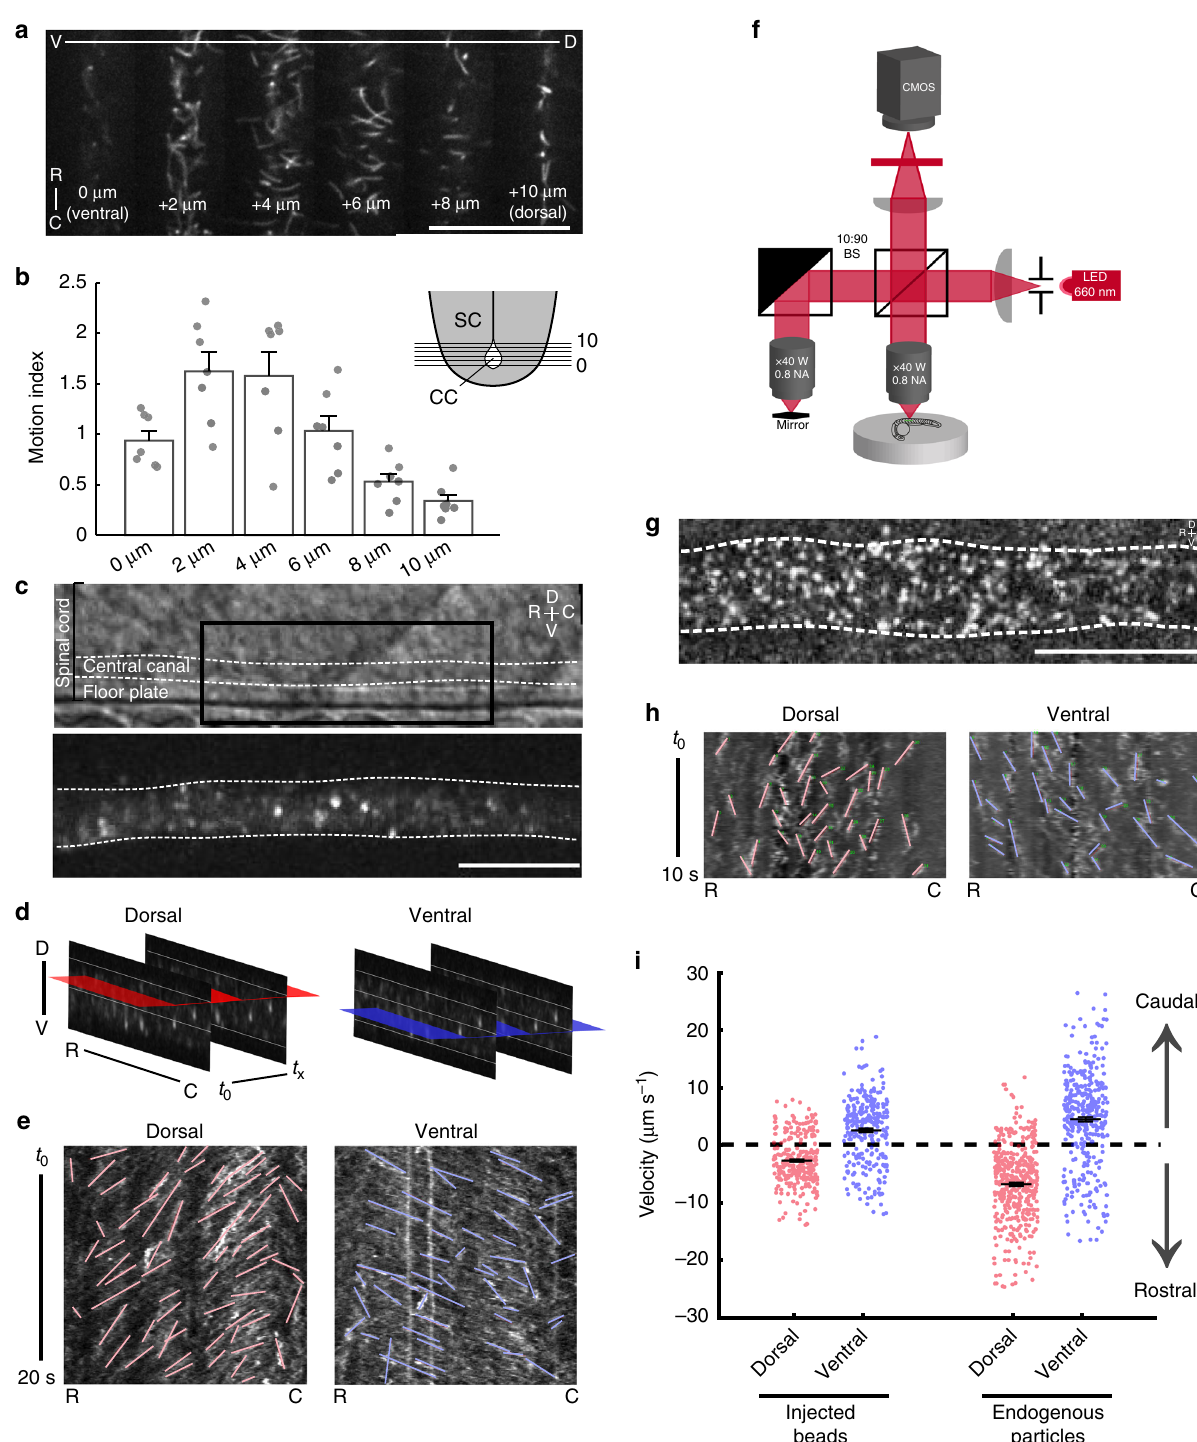
Fig. 1 Bidirectional fl ow of cerebrospinal fl uid in the central canal of the spinal cord. a Single frames from time lapses of 24 h post fertilization (hpf) Tg( β -actin:Arl13B-GFP) embryos expressing GFP in cilia. Images taken from progressively dorsal focal planes. Scale: 25 µ m. b Quanti fi cation of ciliary motion from time lapses; ventral planes exhibit more ciliary motion than dorsal planes (one-way ANOVA F = 12.2, p = 5.92 × 10 ‒ 7 , see Methods for motion index quanti fi cation) SC spinal cord, CC central canal. c Lateral view of the central canal in transmitted light (top) and fi lled with fl uorescent beads (bottom). Scale: 20 µ m. d Schematic of horizontal slices taken for kymograph analysis for velocities of beads or endogenous particles. e Representative kymographs of beads in the central canal. Analyzed trajectories are in red (dorsal) or blue (ventral). f Imaging setup for full- fi eld optical coherence tomography (FF-OCT). g Lateral view of the central canal showing endogenous particles obtained from FF-OCT. Scale: 20 µ m. h Representative kymographs of endogenous particles in the central canal. Analyzed trajectories are in red (dorsal) or blue (ventral). i Velocities of exogenous particles (beads) and endogenous particles. Beads: 307 trajectories from n = 7 embryos; endogenous particles: 452 trajectories from n = 7 embryos. Error bars represent s.e.m. D dorsal, V ventral, R rostral, C